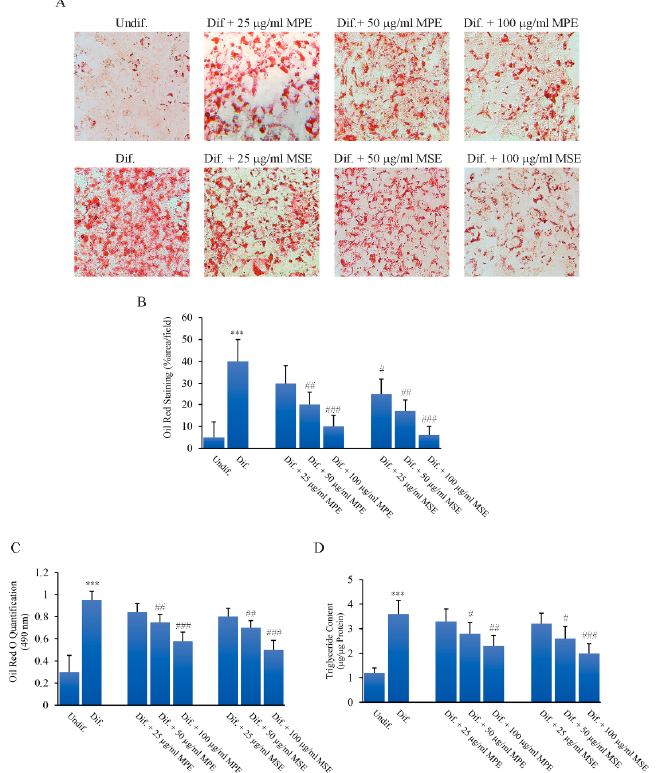
Figure 3. MPE and MSE reduce lipid content in 3T3-L1 adipocytes. 3T3-L1 cells were treated with pro-differentiative agents for 8 days in the presence or absence of different concentrations (25, 50 and 100 µ g/mL) MPE or MSE, as reported in Methods. Representative photographs showing LDs reduction by Oil red O staining after MPE and MSE treatment (200 × original magnification) ( A ). Lipid droplets (LDs) content was ascertained by analyzing the percentage area Red Oil stained by Image J ( B ) Quantitative Oil red O staining measured by spectrophotometer at 490 nm reading ( C ). Cellular TGs content quantified by spectrophotometer at 546 nm reading ( D ). The results are the mean of three independent experiments ± SD. *** p < 0.001 with respect to the undifferentiated cells (Undif.). # p < 0.05, ## p < 0.01 and ### p < 0.001 with respect to the differentiated untreated cells (Dif.).